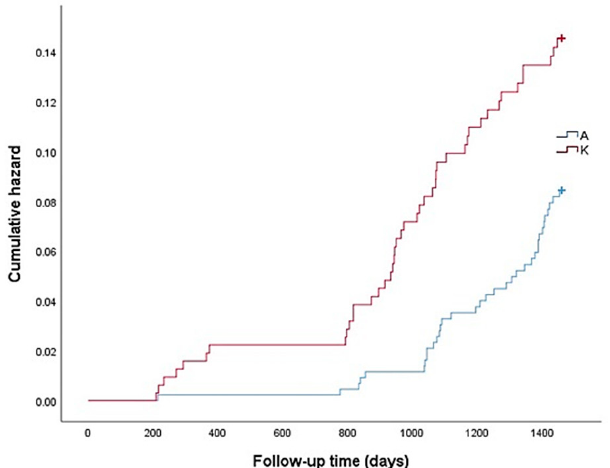
Figure 2. Kaplan–Meier curves for cumulative hazard of incident disability during the 4-year follow-up period in districts A ( ― ) and K ( ― ).